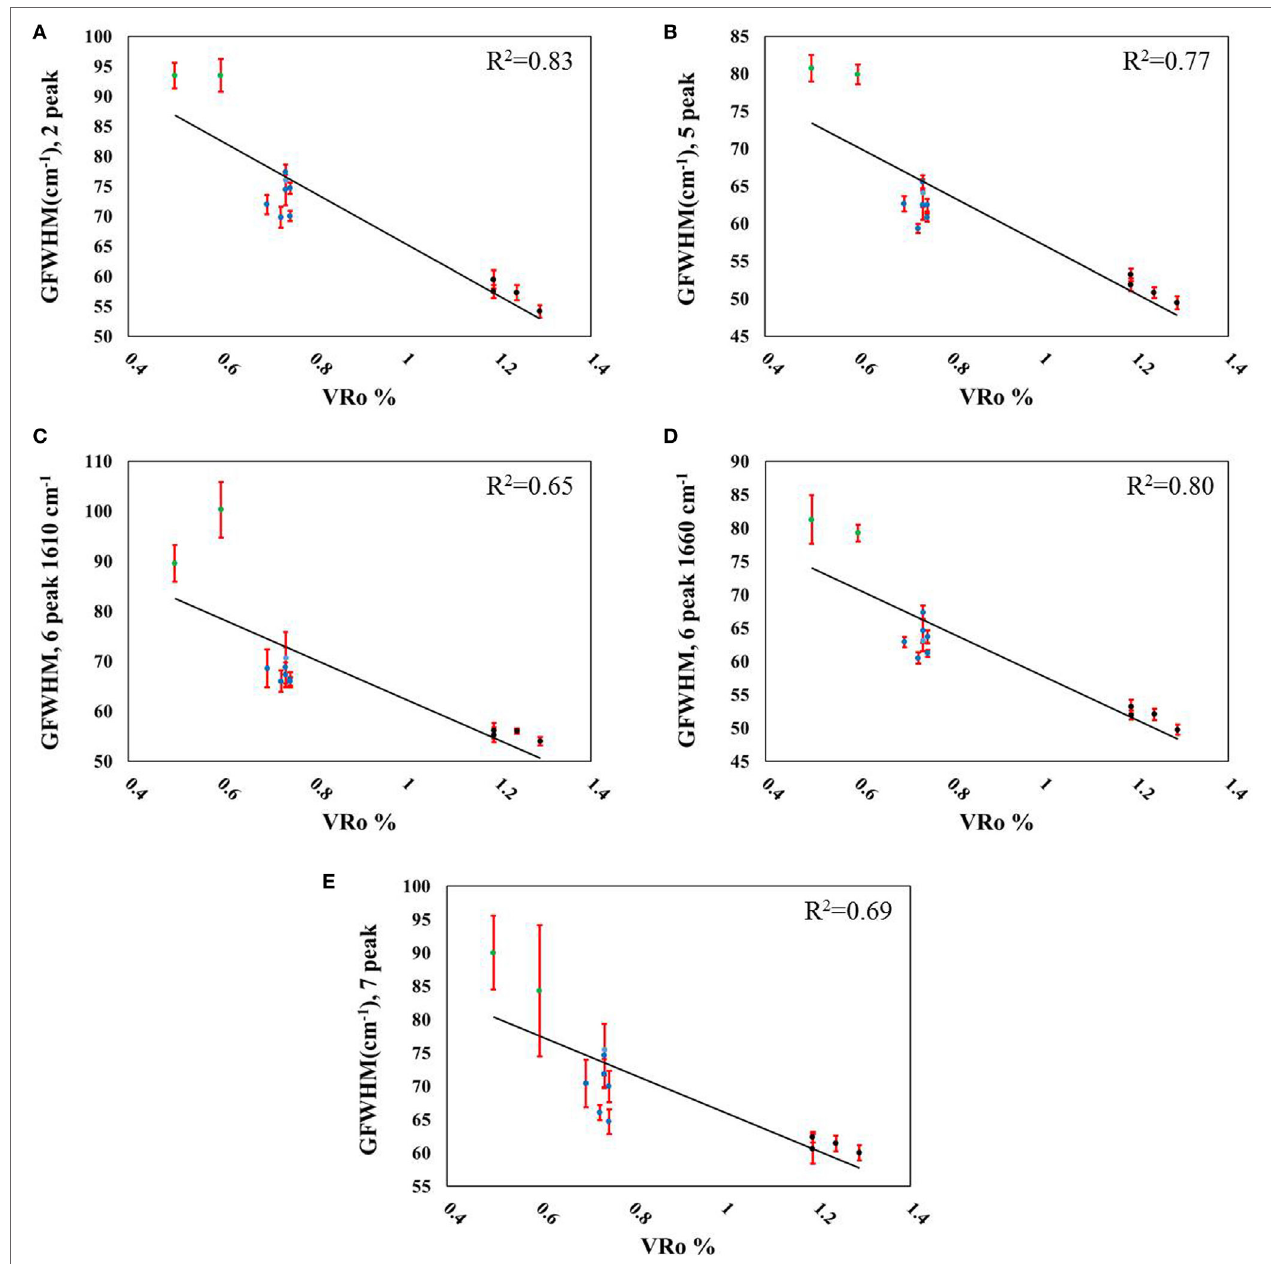
FigUre 7 | Correlations between G-FWHM and measured VRo% using (a) two peaks ( R 2 = 0.83), (b) five peaks ( R 2 = 0.77), (c) six peaks including the D2-band ( R 2 = 0.65), (D) six peaks including a ~1,660 cm − 1 peak ( R 2 = 0.80), and (e) seven peaks ( R 2 = 0.69). Data point legend: green = Aristech wells, blue = Interstate/ Columbia wells, black = EQT